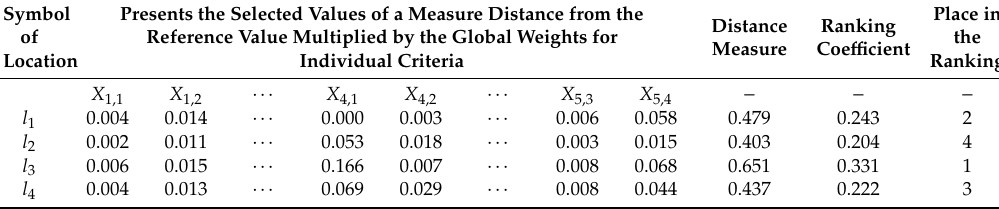
Table 12. Calculated values of distance measure and ranking coe ffi cient values. Symbol of